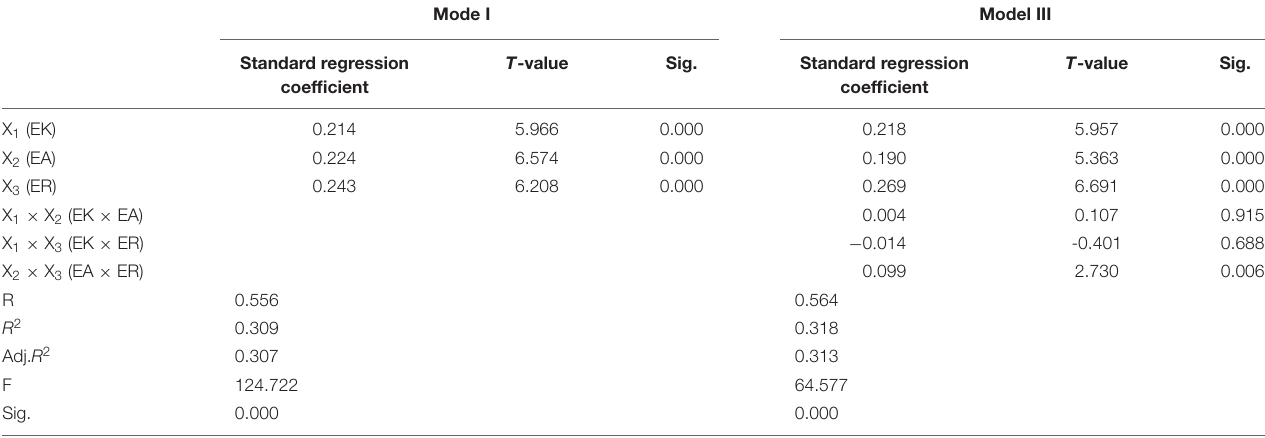
TABLE 3 | Test results of the main effects and interaction effects of various components of pro-environmental awareness on green consumption. Mode I Model III Standard regression T -value Sig. Standard regression T -value coefficient coefficient